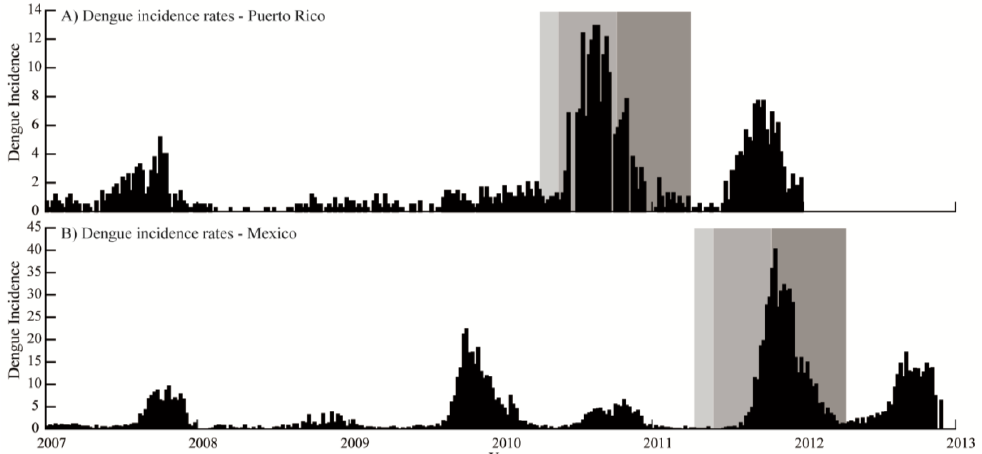
Figure 3. Dengue fever incidence rates distributions for San Juan, Puerto Rico and the northwest region of Yucatan, Mexico. Dengue incidence rates per 100,000 inhabitants from 2007 to 2012 for ( A ) San Juan, Puerto Rico; and ( B ) northwest coast of Yucatan, Mexico. Data only includes these years to show patterns and epidemic years, which for both locations were 2007 and 2011. The three shaded gray boxes represent the pre-epidemic (weeks 10–20), epidemic (weeks 21–40), and post-epidemic (weeks 41–49) periods.